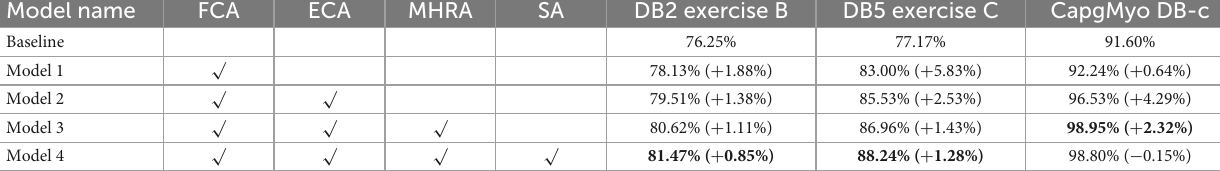
TABLE 1 Hand gesture recognition accuracy achieved on each dataset in the ablation